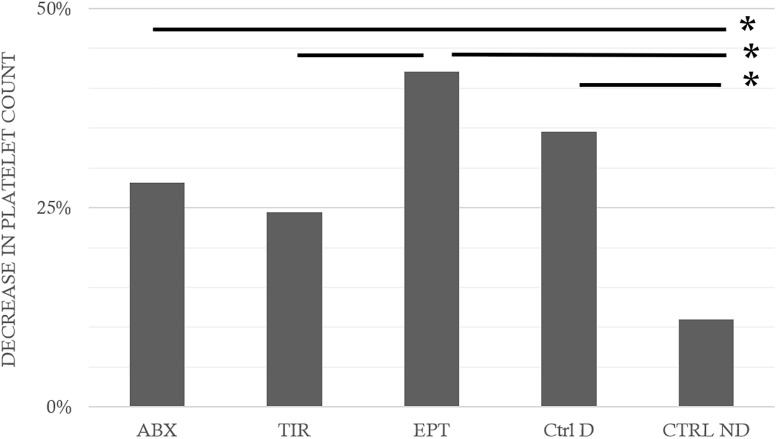
Fall in platelet counts following the hyperbaric exposure according to the treatment groups. ABX: Abciximab; TIR: Tirofiban; EPT: Eptifibatide; Ctrl D: Control Dive; Ctrl ND: Control No Dive. ∗ notes significant difference (p < 0.05) between groups.